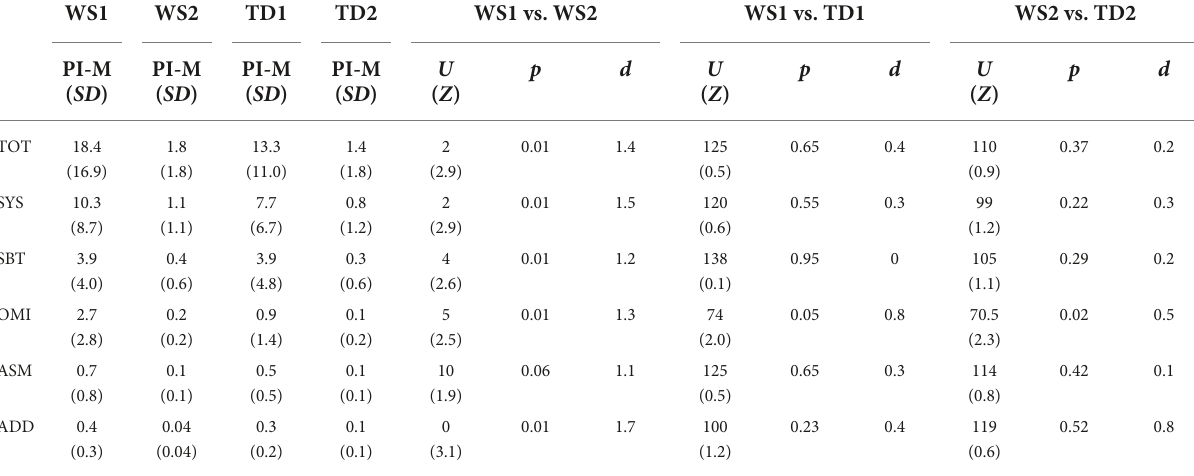
TABLE 2 Phonological processes index (total and by classes) means and standard deviations for groups, Mann–Whitney U test, and effect size.